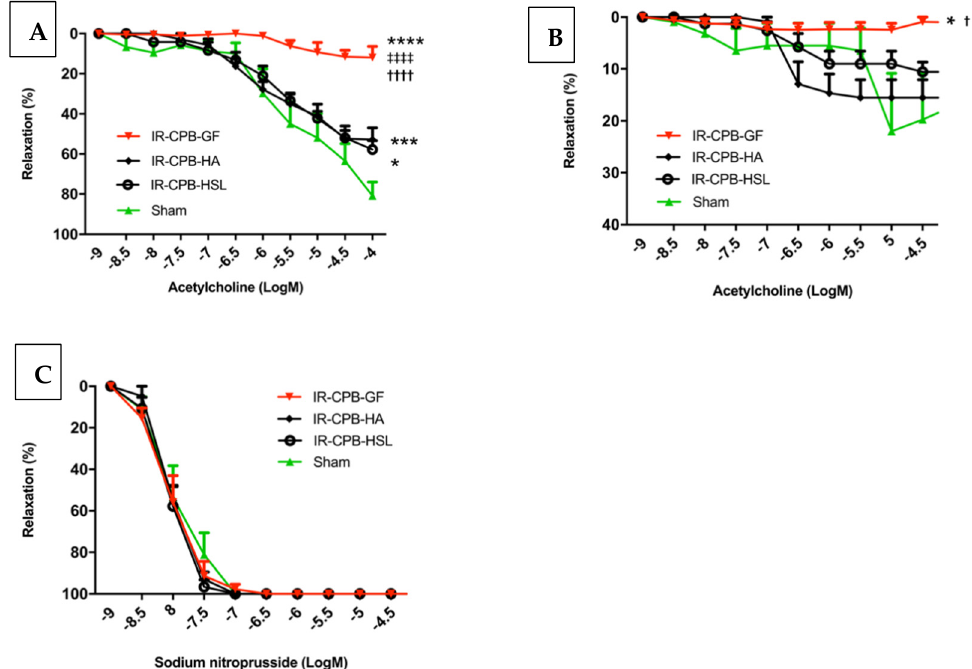
Figure 1. In vitro vascular responses. ( A ) Relaxation to acetylcholine after precontraction with phenylephrine (endothelium-dependent relaxation). * p < 0.05 vs. sham. *** p < 0.001 vs. sham. **** p < 0.0001 vs. sham. †††† p < 0.0001 vs. HA. ‡‡‡‡ p < 0.0001 vs. HSL. ( B ) Relaxation to sodium nitroprusside after precontraction with phenylephrine (endothelium-independent relaxation). ( C ) Relaxation to acetylcholine after precontraction with phenylephrine with L-NNA. * p < 0.05 vs. sham. † p < 0.05 vs. HA. For statistical analyses, ANOVA was used for repeated measurements, followed by Tukey’s multiple comparison (post hoc) testing. The concentrations of acetylcholine and sodium nitroprusside were expressed by the logarithmic decimal value of their molarity ( A – C ). A result with p < 0.05 was considered to be statistically significant. For ( A – C ), responses are expressed as percentage relaxation of phenylephrine-induced precontraction (mean ± SEM) ( n = 5 per group). Abbreviations: CPB, cardiopulmonary bypass; IR, left lung ischemia–reperfusion; HA, human albumin; HSL, hypertonic sodium lactate; Log [M], logarithm decimal of molarities.